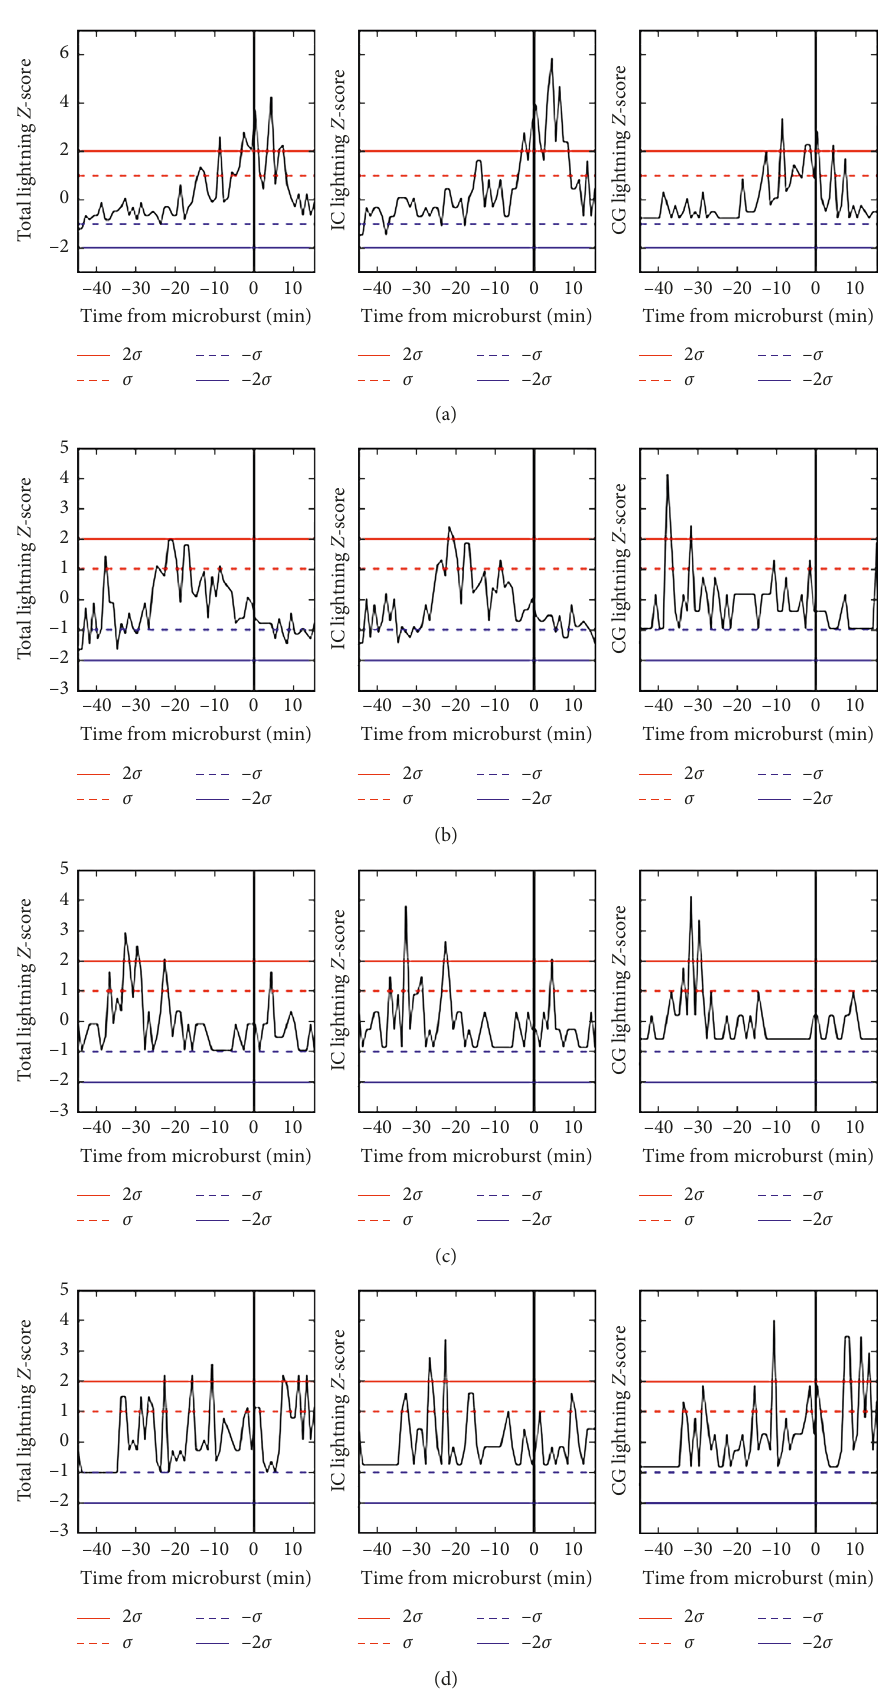
Figure 13: As in Figure 12, but for the last four severe wind cases. (a) 20150623 null. (b) 20150630 null. (c) 20150803 null. (d) 20160701